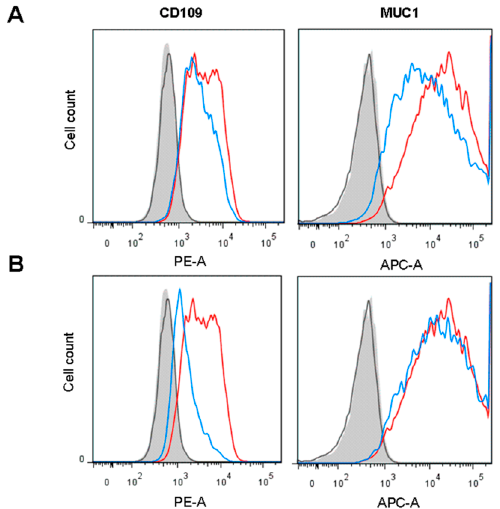
Figure 6. CD109 and MUC1 surface expression decrease in fluorescence-activated cell sorting (FACS) induced by F 2 -Gal and acetylated F 2 -Gal-1-P. ( A ) FACS separation diagram of HEK293-MUC1 cells grown in the absence (red) or presence of F 2 -Gal (blue). Cells were cultured in low-Glc / low-Gal medium. ( B ) FACS diagrams of HEK293-MUC1 cells grown in the absence (red) or presence of acetylated F 2 -Gal-1-P (blue). Cells were cultured in low-Glc / low-Gal medium.